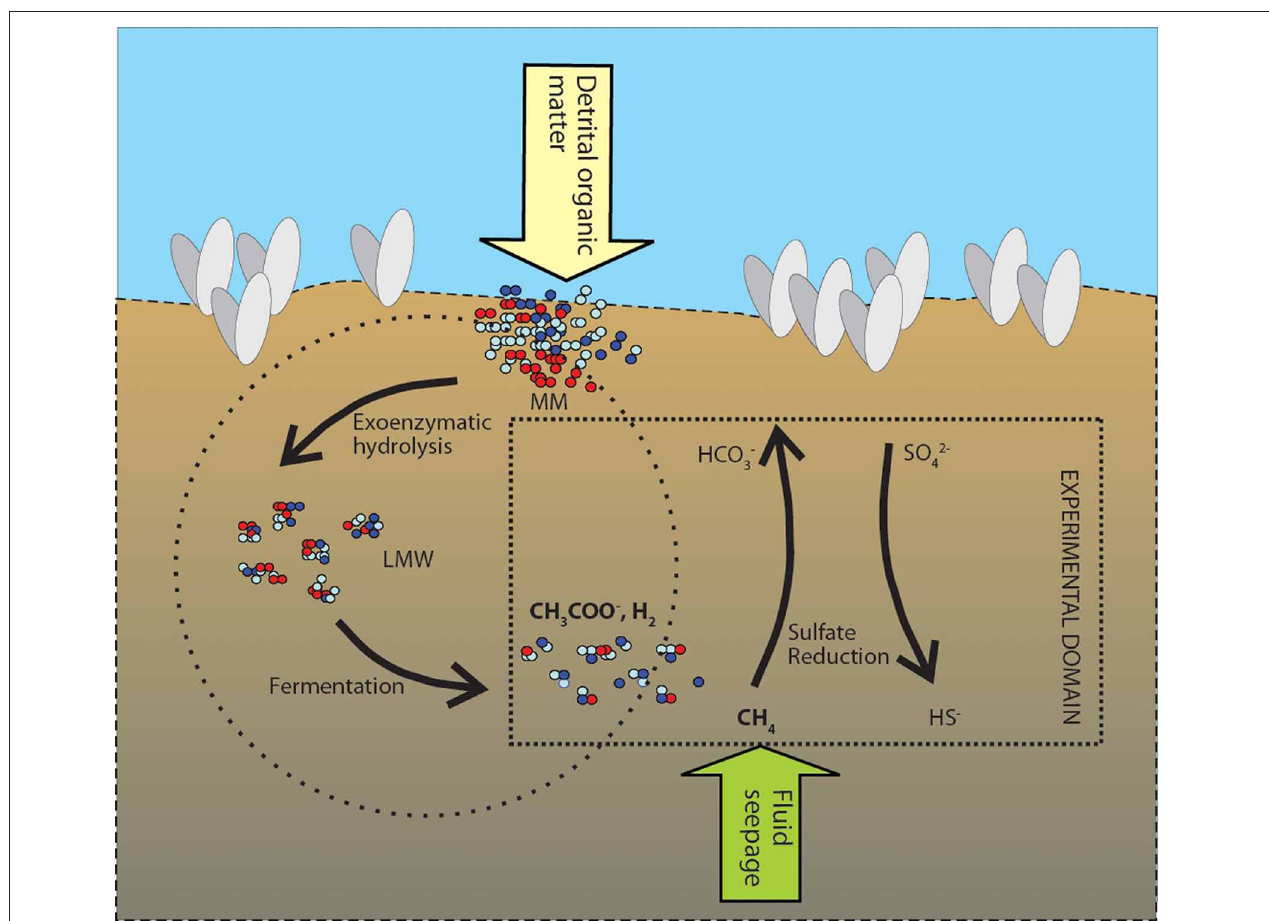
FIGURE 1 | Model of the anaerobic food web coupled to sulfate as the terminal electron accepting process (after Jørgensen, 2006) for the Japan Trench sediments. Detrital organic matter is buried in the surface sediment as macromolecules (MM). During exoenzymatic hydrolysis macromolecules are broken down to low molecular weight molecules (LMW). Fermentation further degrades LMW to short chain fatty acids such